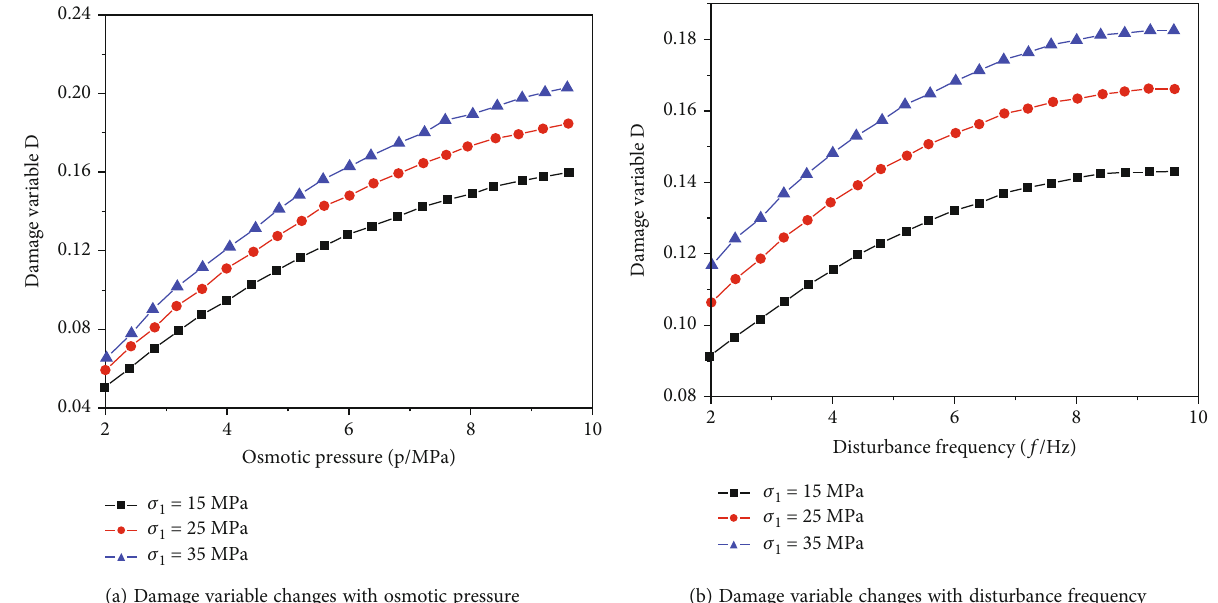
Figure 8: The in fl uence of p and f on the damage variable D